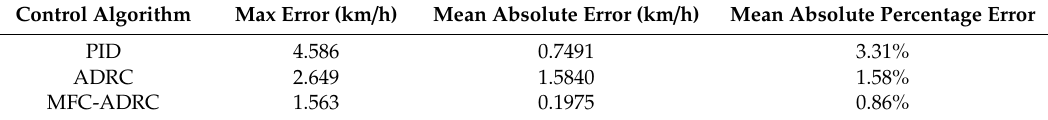
Figure 6. Speed tracking results for Case 2. Table 3. Tracking error statics with vehicle mass 1800 kg and incline 0 ◦ Table 4. Tracking error statics with vehicle mass 2100 kg and incline 6°.